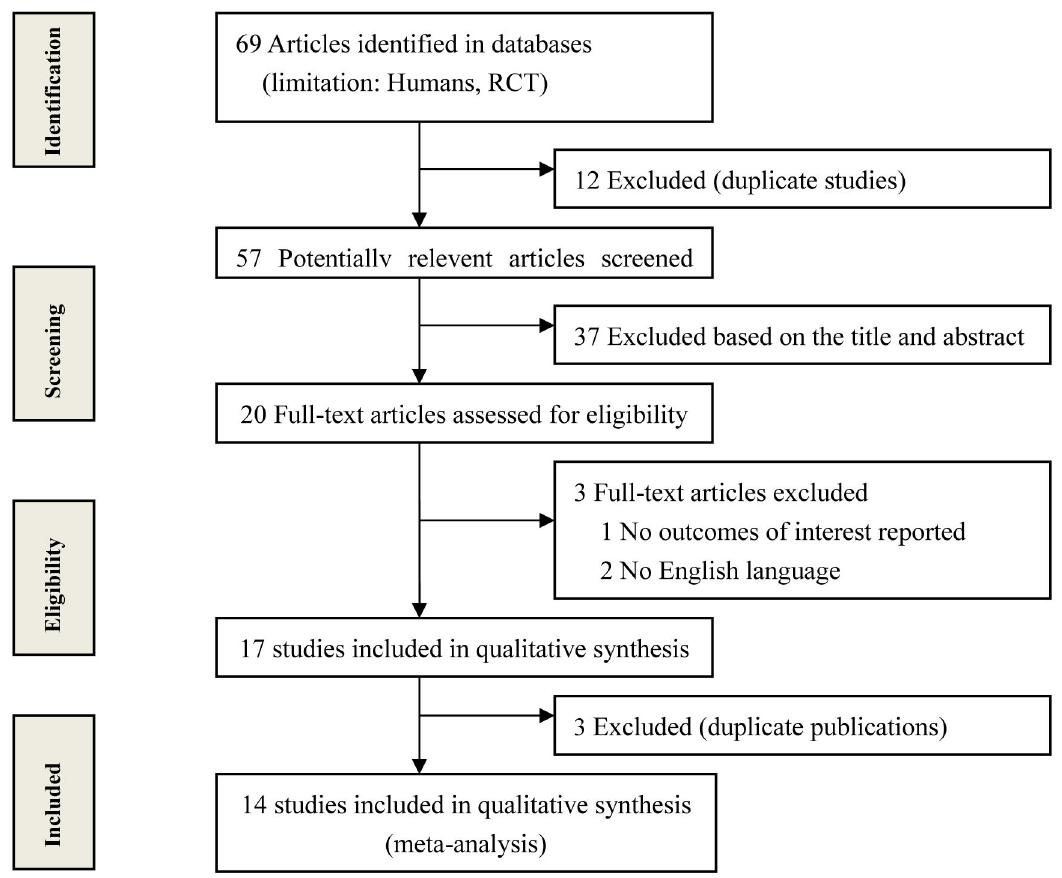
Figure 1. Flow chart of eligibility